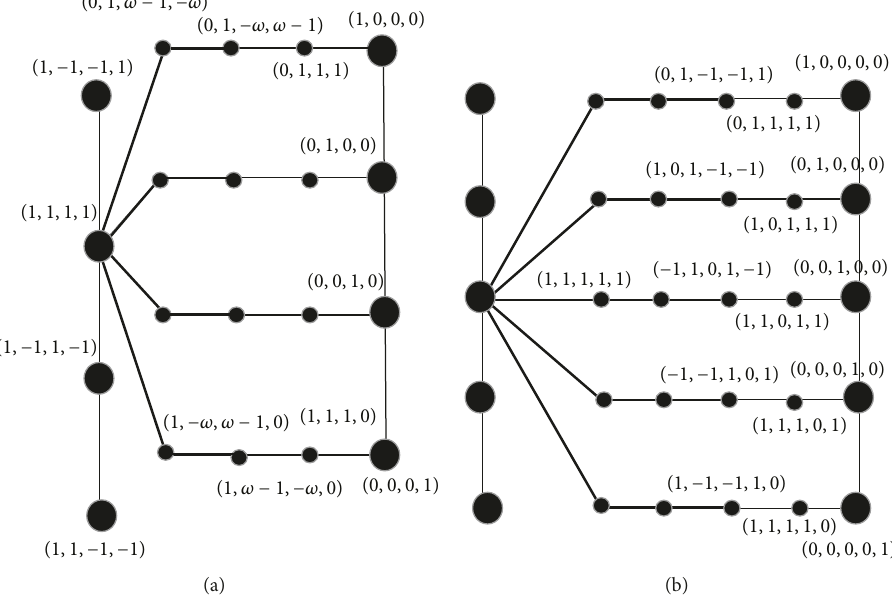
Figure 2: (a) Maximum cliques of orthogonal rays from two-qubit permutation gates: 6 4-tuples (thin lines) and 4 triples (thick lines), 𝜔 = exp (𝑖𝜋/3) . Missing coordinates are straightforward to recover. (b) Maximum cliques of orthogonal rays from 5-dit permutation gates: 7 5-tuples (thin lines) and 5 4-tuples (thick lines). Big black bullets are for stabilizer states; small black bullets are for magic